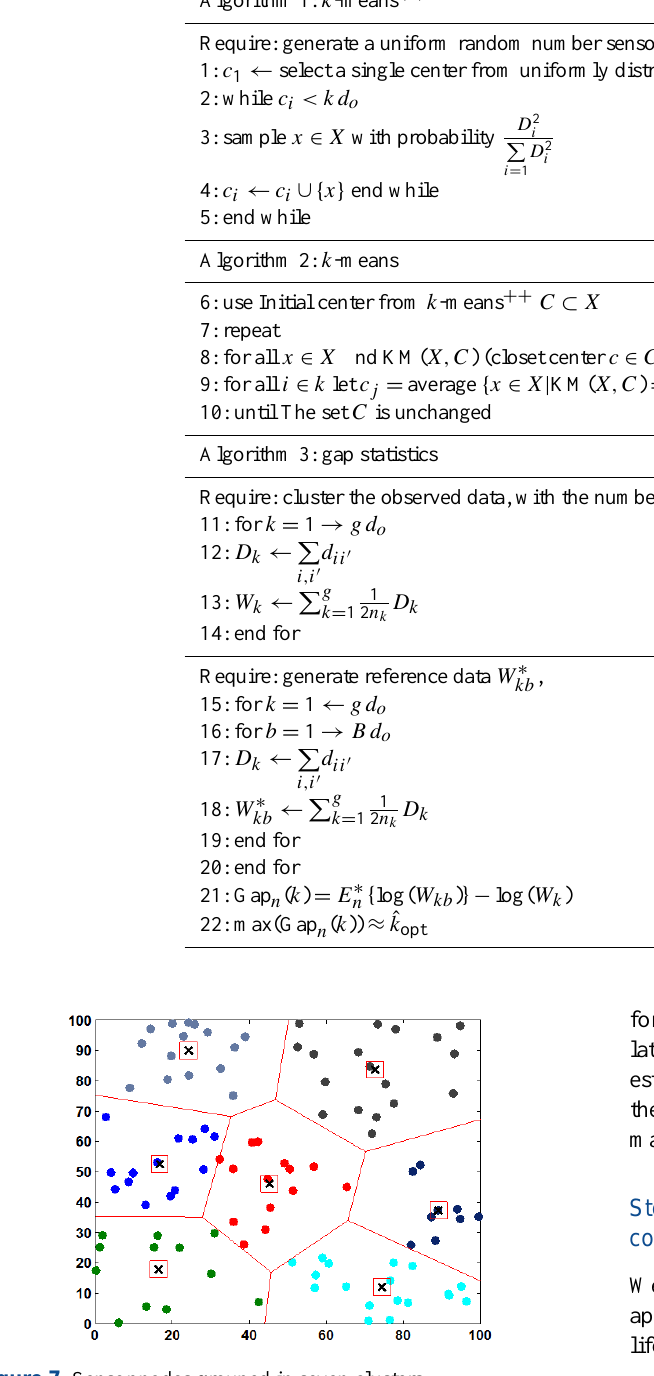
Figure 8 shows the observed and reference weight func- tions versus the number of clusters. In addition, the red dots on the red curve are the observed weight curve (log( W k